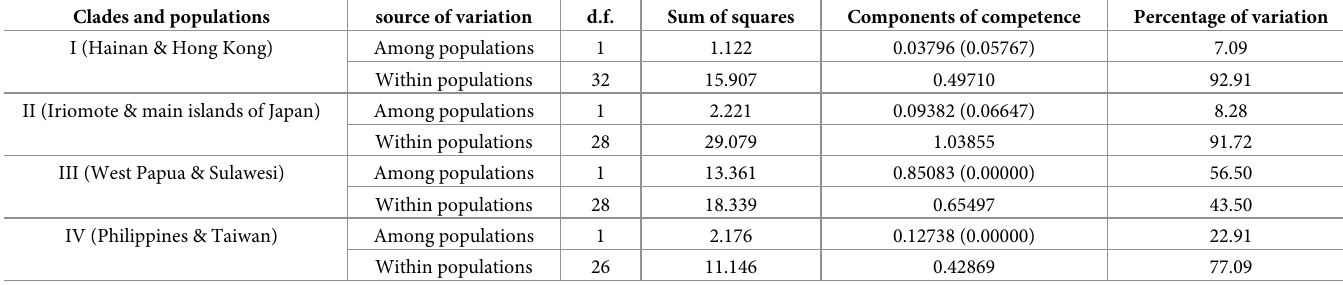
Table 2. AMOVA. Summary of hierarchical analysis of molecular variance (AMOVA) based on 618 bp of Cox1 (the 3’ end). Clades and